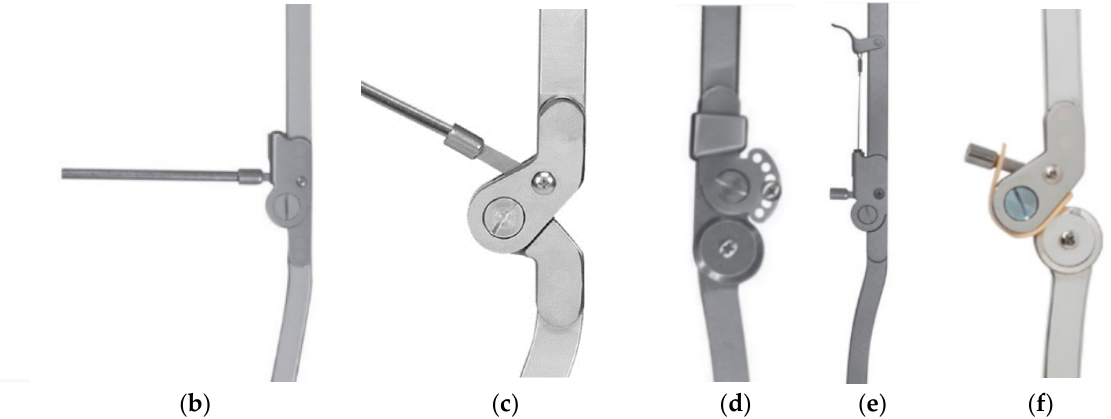
Figure 4. ( a ) Ring lock knee joint, ( b ) Automatic spring lever knee joint, ( c ) Posterior offset lever lock knee joint, ( d ) Adjustable extension/flexion ring lock knee joint, ( e ) Automatic trigger lock Knee joint, ( f ) Adjustable posterior offset knee joint [16].